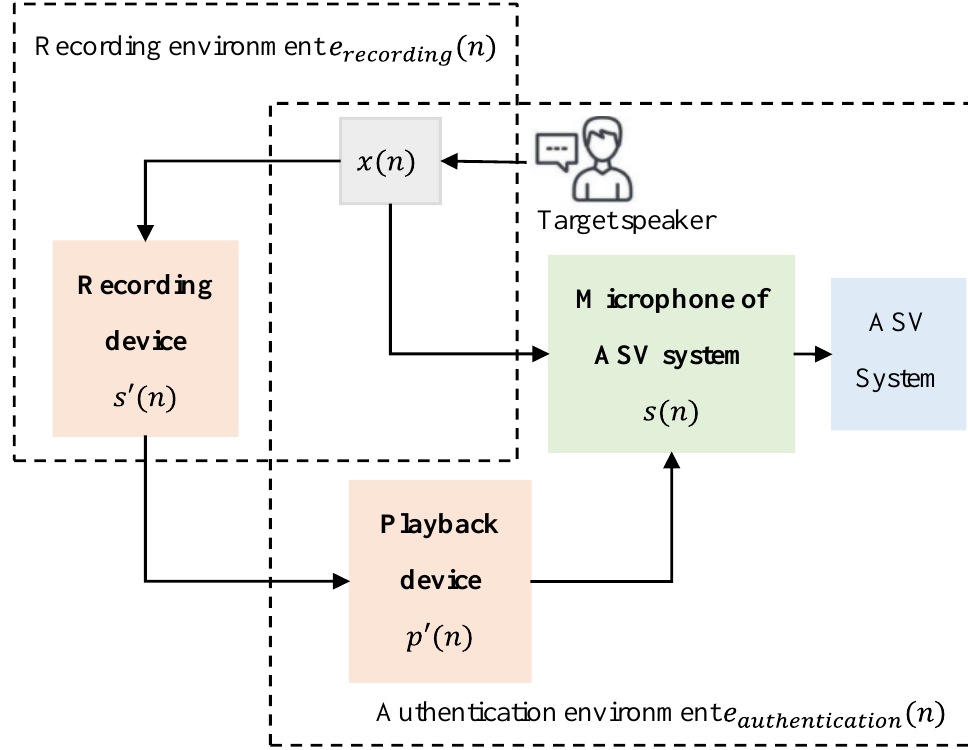
Figure 2. The generation and authentication process of the replay signal.